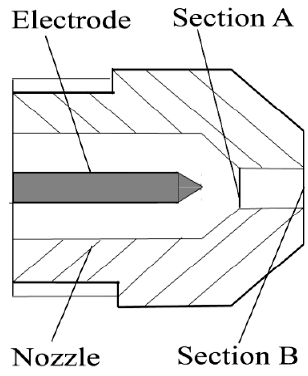
Figure 4. Internal structure of the nozzle.